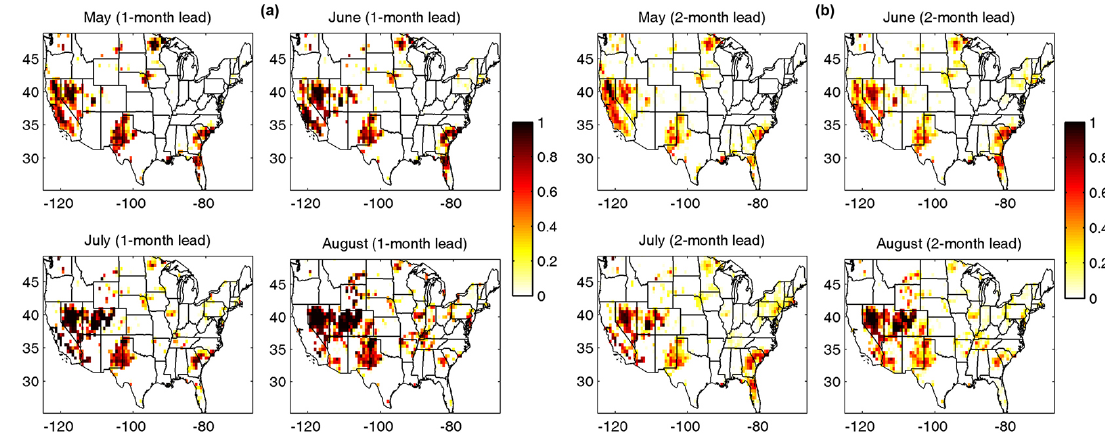
Figure 4. (a) The 1-month and (b) 2-month lead drought probability predictions for May–August 2012 for SSI6 < − 1 .